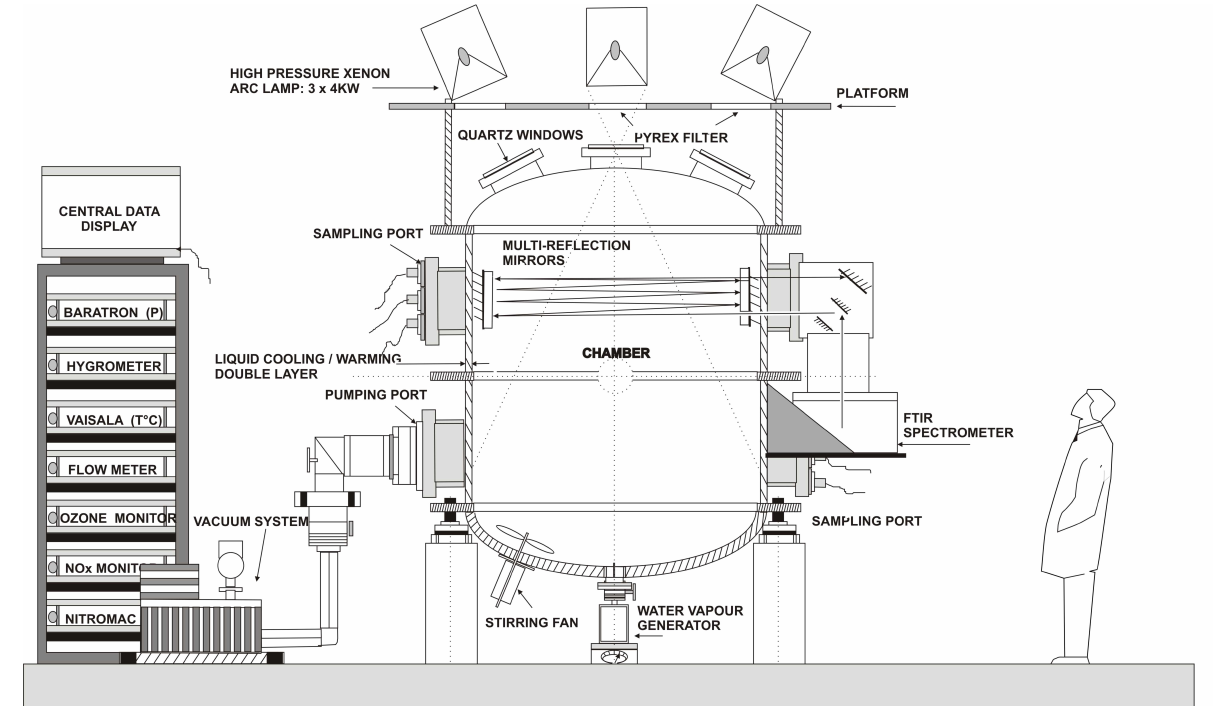
Fig. 1. Schematic front view of the CESAM